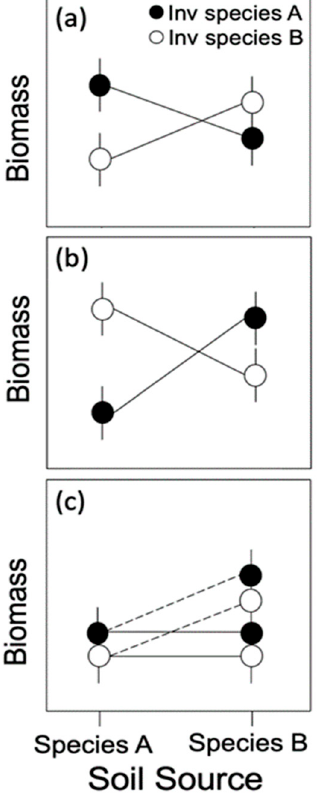
Figure 1. Theoretical outcomes of invasive-invasive net pairwise plant-soil feedback could potentially include ( a ) positive feedback due to novel weapons and / or competition for limiting soil resource(s), ( b ) negative feedback indicative of niche partitioning or joint facilitation, or ( c ) neutral feedback due to mutual enemy escape and / or generalist soil mutualists (solid horizontal lines) or facilitation by a nitrogen fixer (dashed lines).